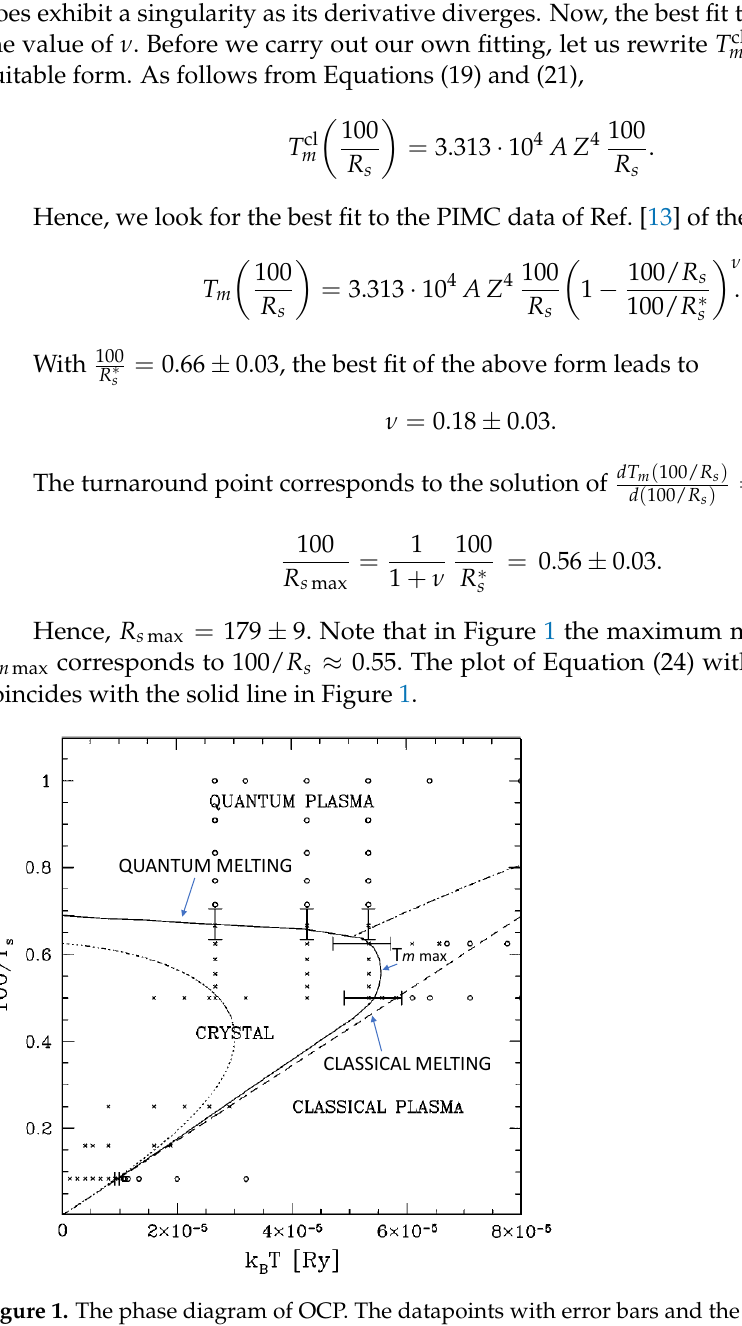
Figure 1. The phase diagram of OCP. The datapoints with error bars and the solid line as their best fit come from PIMC simulations of Ref. [13]. The short-dashed line represents the results of the theoretical calculations of Ref. [14]. Reprinted/adapted with permission from Ref. [13]; APS Reuse and Permissions License RNP/22/NOV/059640 of 2 November